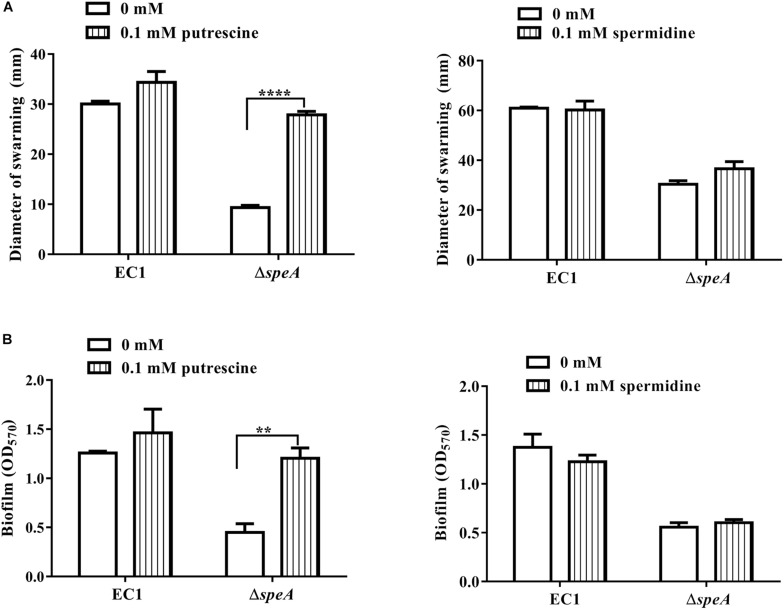
Effect of exogenous addition of putrescine or spermidine on swarming motility and biofilm formation. (A) Swarming motility of EC1 and its derivatives in the presence of 0.1 mM putrescine or spermidine, respectively, the diameter of warming zone was measured at 24 h after inoculation. (B) Effect of putrescine or spermidine on biofilm formation at a final concentration of 0.1 mM. The data shown are the means ± SE (n = 3). ****P < 0.0001, ∗∗P < 0.01.